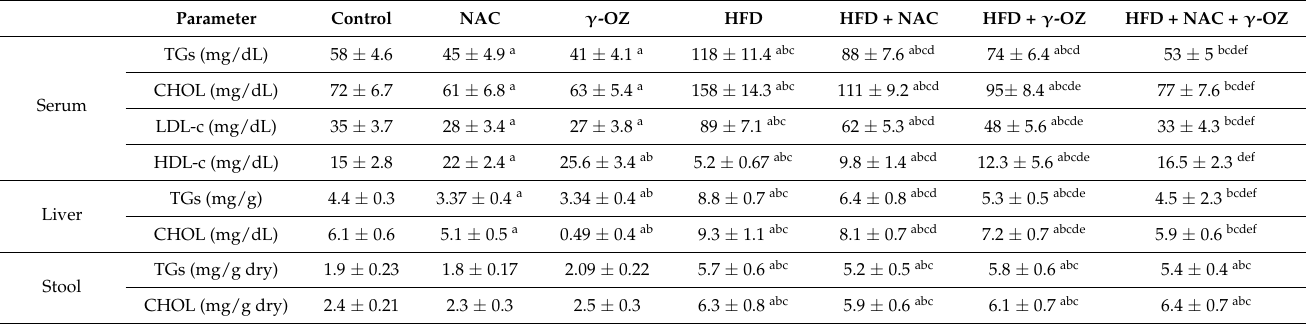
Table 3. γ -Oryzanol (OZ) and N-acetylcysteine (NAC) and their combination improve lipid profile in the serum and livers of high-fat-diet (HFD)-fed rats.